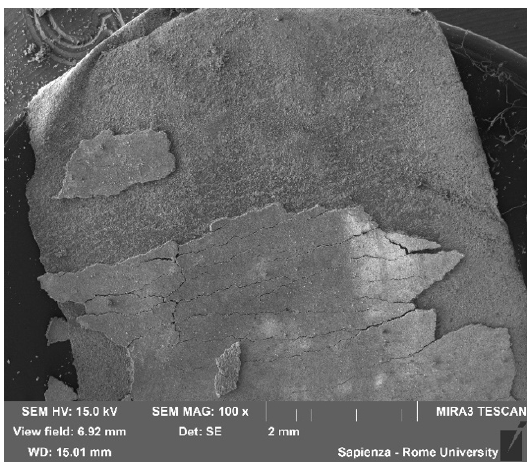
Figure 13. SEM image (1000×) of the cathode after the cone calorimeter test A4. From comparison of SEM images of the electrodes before and after cone calorimeter tests it clearly appears that both electrodes’ surfaces are not homogeneous (Figure 14).